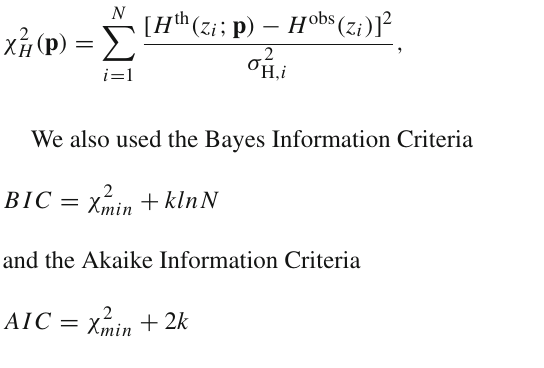
evolution of deceleration parameter for best fitted , + 1 σ and − 1 σ of best fitted parameters for CC data and Fig. 4 show the evolution of the deceleration parameter against redshift for the best fitted parameters and initial conditions for differ- ent data set. It shows that the model allows transition from a phase (dark energy epoch) for more than one